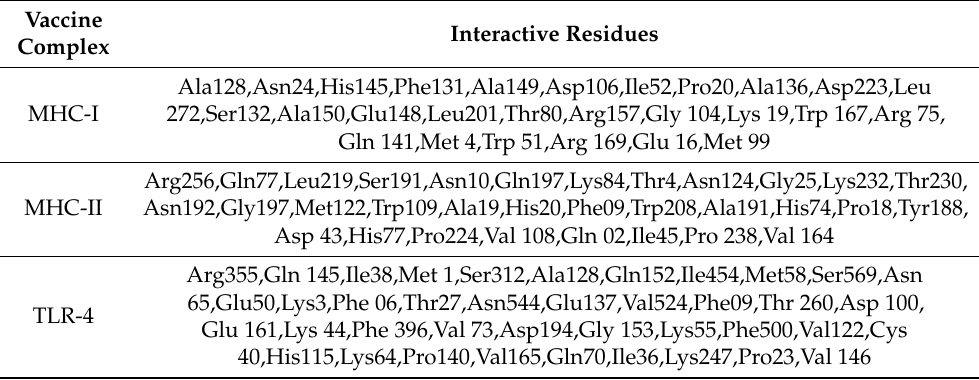
Table 5. Residues wise interaction of vaccine construct to